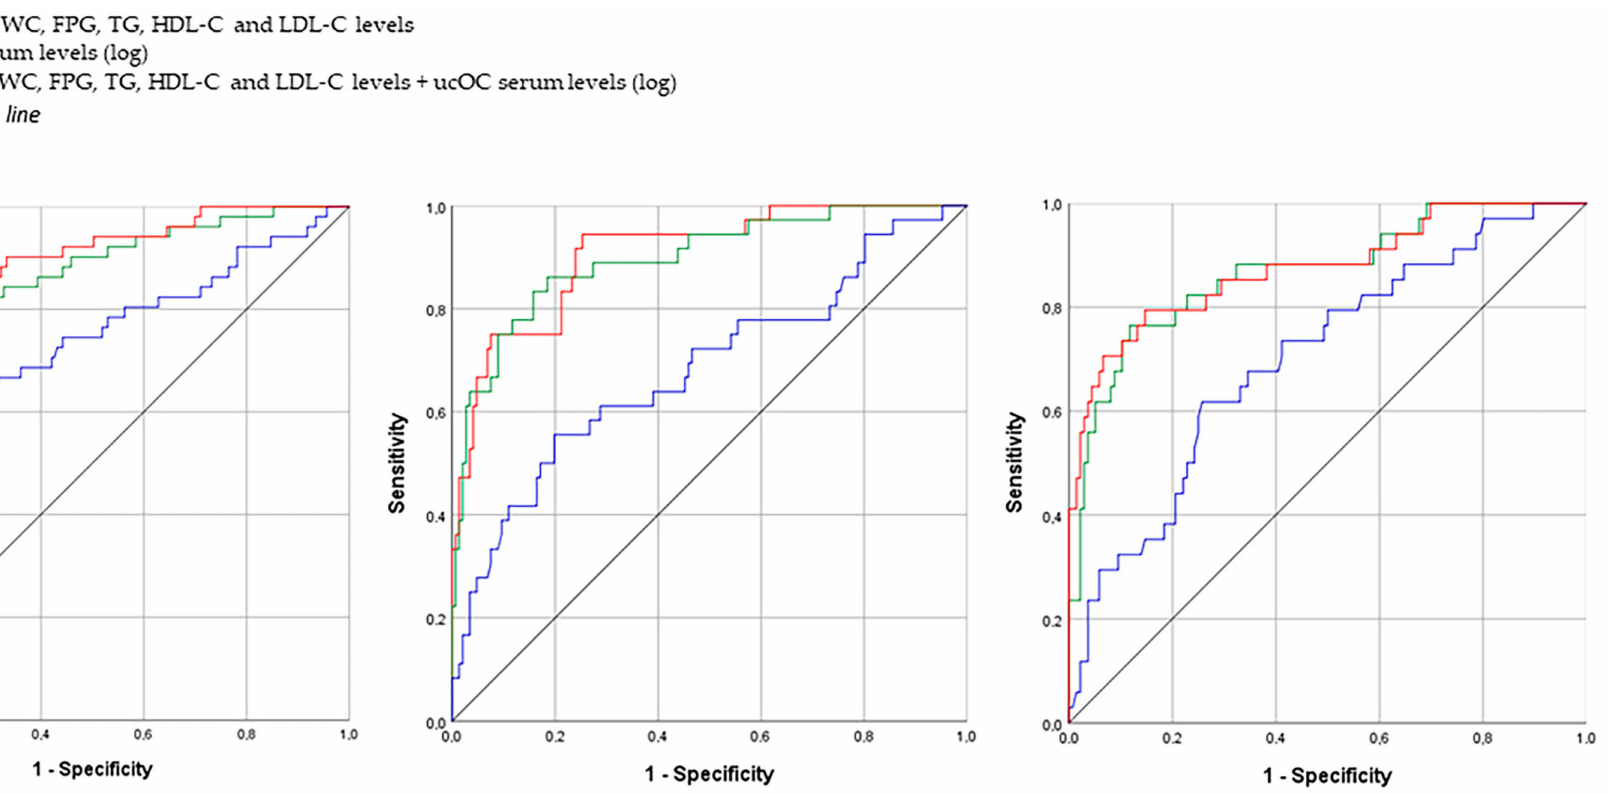
Figure 2. ROC curve to analyze the utility of ucOC serum levels (log) as an indicatorof T2D prevalencein MetS patients at baseline and after the 6- and 12-month follow up. ucOC: undercarboxylated osteocalcin. FPG: fasting plasma glucose; HDL: high-density lipoprotein; LDL: low-density lipoprotein; ucOC: undercarboxylated